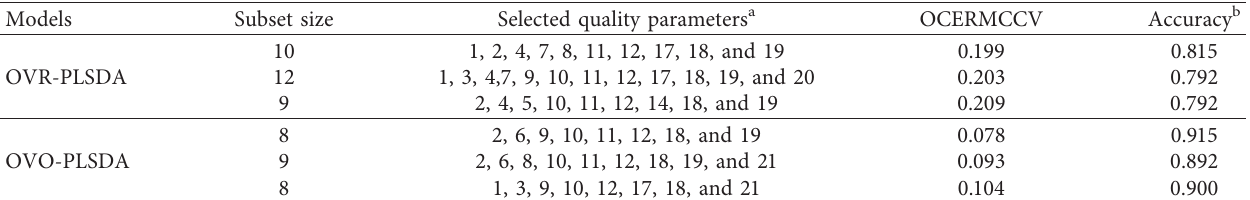
Table 4: Classification results of 12 cultivars of blueberries using optimized subsets of quality parameters.